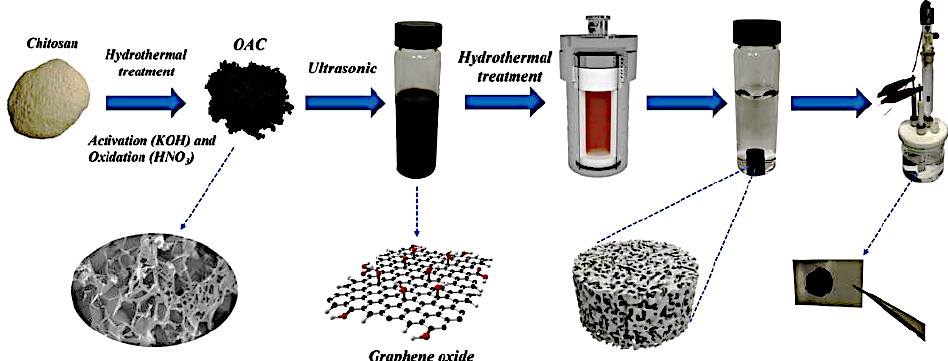
Figure 5. Schematic representation of composite hydrogel synthesis by a hydrothermal reaction. Adapted from reference [32]. This article is an open-access article distributed under the terms and conditions of the Creative Commons Attribution (CC BY-NC-ND 4.0)